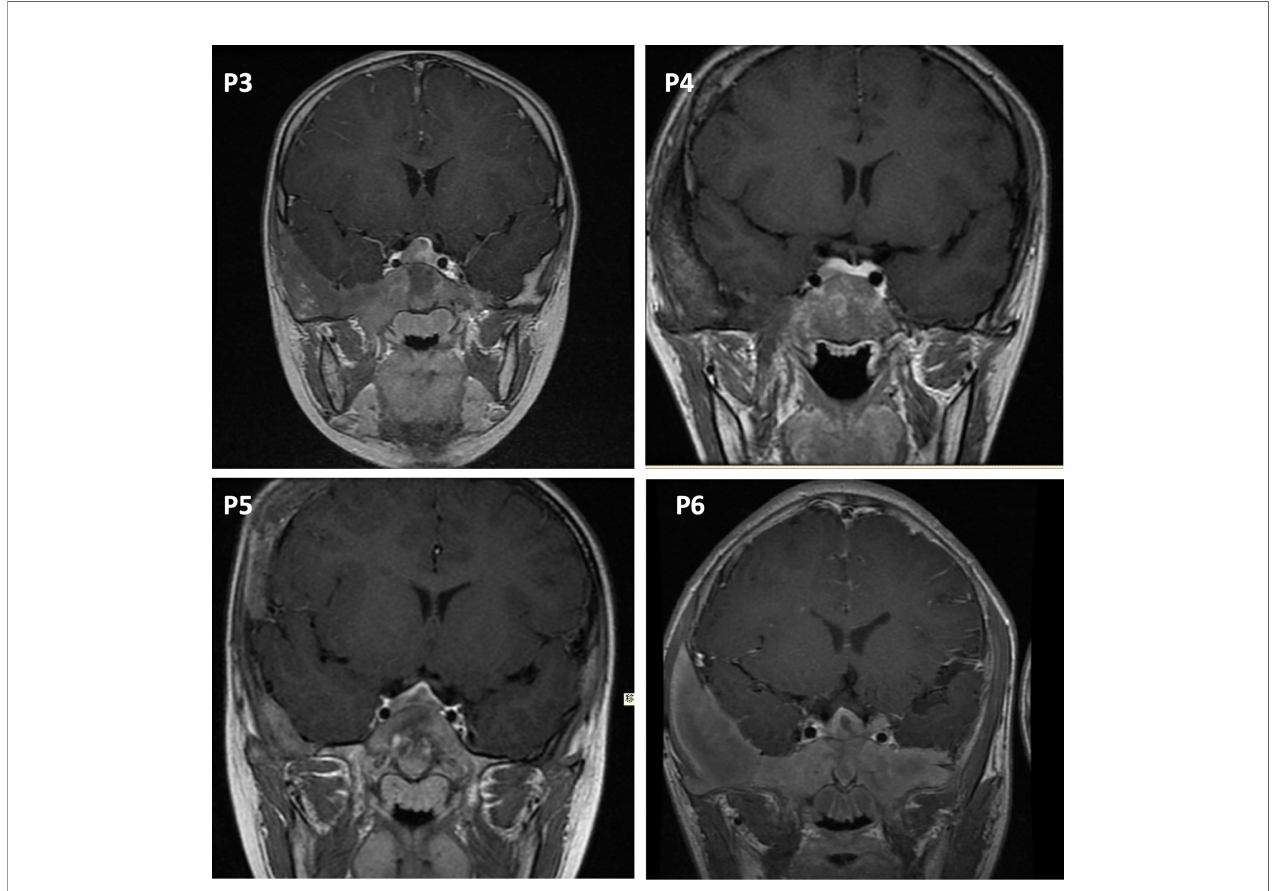
FIGURE 2 | Pituitary MRI in the coronal view. P3, patient 3, macroadenoma. P4, patient 4, microadenoma. P5, patient 5, multiple microadenomas. P6, patient 6, macroadenoma with a cystic